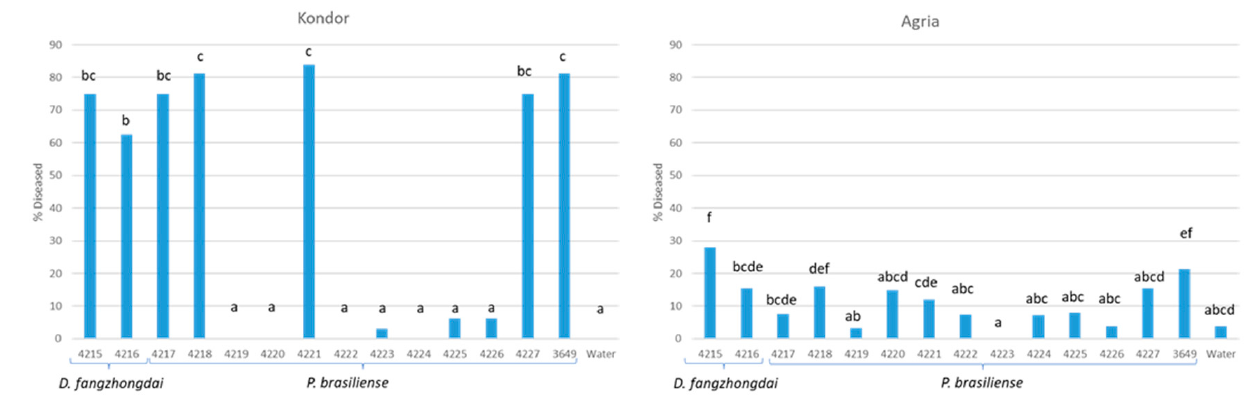
Figure 3. Disease prevalence of a potato crop after vacuum-infiltration of seed tubers of cv. Kondor and cv. Agria with Dickeya fangzhongdai or Pectobacterium brasiliense strains. Bars labelled with an identical character are not significantly different ( p = 0.05).